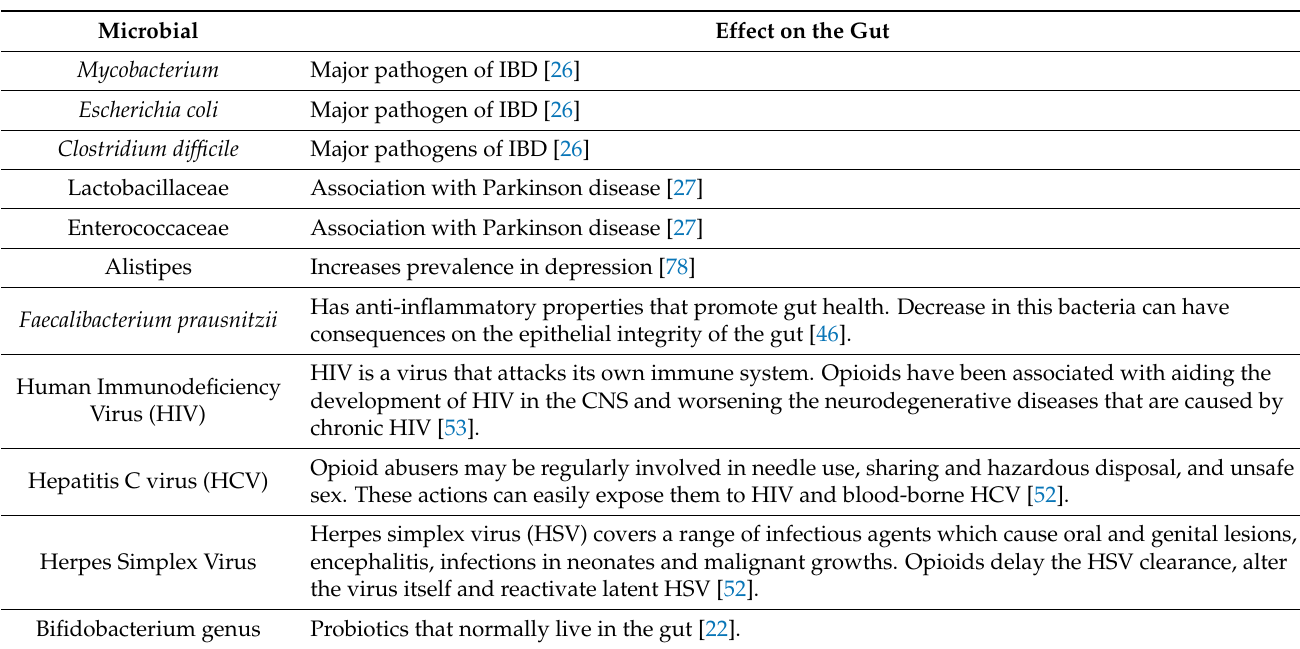
Table 2. Summary of microbials related to the